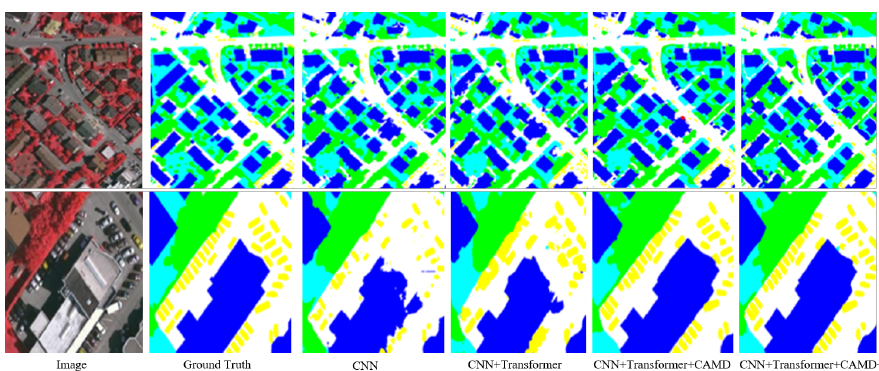
Figure 14. The improvement effect of the overall and local remote sensing images.